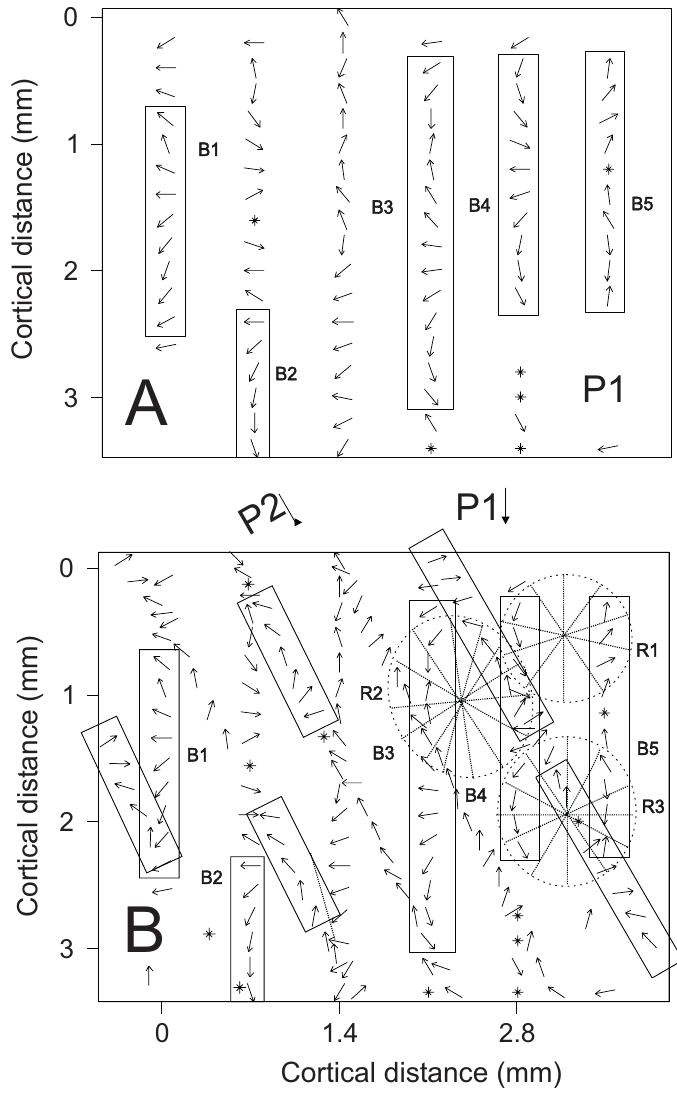
Fig. 3 – Patterns of direction-of-motion arrangement revealed by a manual study (hand plot) of receptive fields in P1 and P2. Small arrows show the direction-of-movement selectivity for each recording site. The ellipses (dotted) show radial arrangements or pinwheels (R1-R3), and the rectangles show linear arrangements in band (B1-B5). The panel in A is the result of the study in a recording plane with six simultaneously driven microelectrodes (P1). The lower panel (B) is a representation of the direction selectivity in two superposing oblique crossing planes (P1+P2). Note that each plane of penetration was reconstructed from successive 40 µ m-thick oblique sections containing the electrode tracks. The reconstructed plane was treated as a single oblique plane containing the entire set of electrode